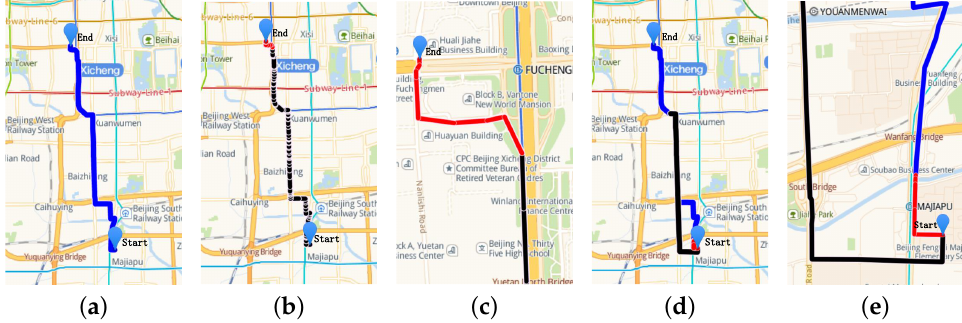
Figure 6. Example of long distance between start and end. ( a ) The route when traffic is free. ( b ) The jam is close to the end. ( c ) Detail of jam near the end in ( b ). ( d ) The jam is close to the start. ( e ) Detail of jam near the start point in ( d ).